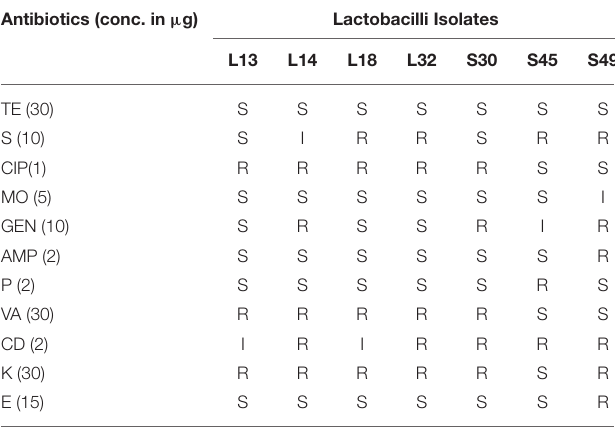
TABLE 6 | Antibiotic susceptibility profile of fecal lactobacilli isolates. Antibiotics (conc. in µ g)